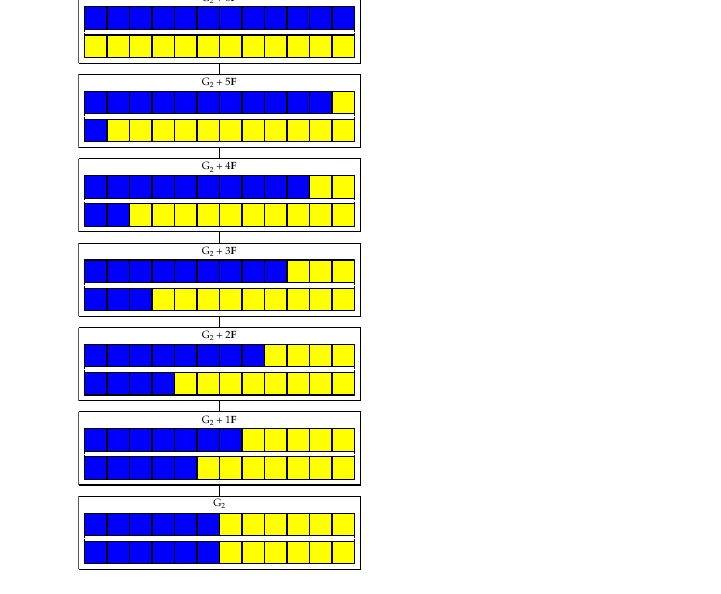
Figure 38. The tree of descendants for G 2 +6 F , which is gauge theory description for the marginal theory obtained from SU(3) on a ( (cid:0) 1)-curve with 12